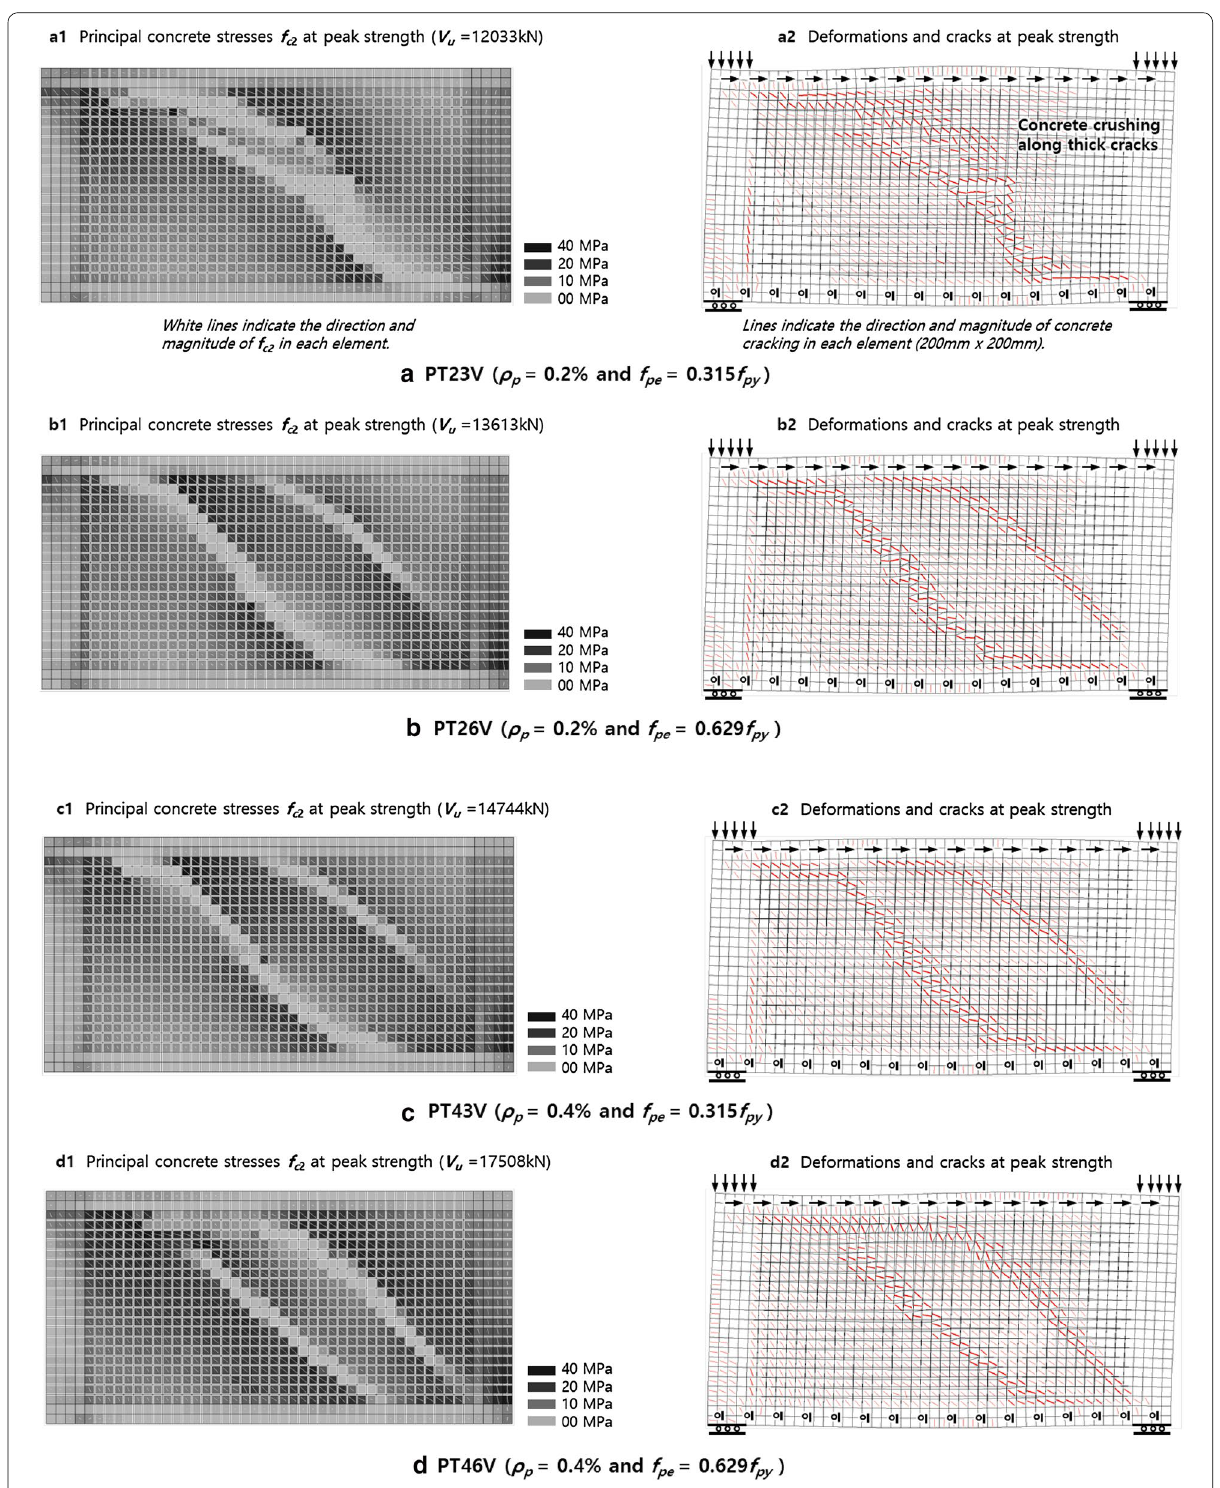
Fig. 15 Distributions of concrete stress, deformation, and cracks by FE